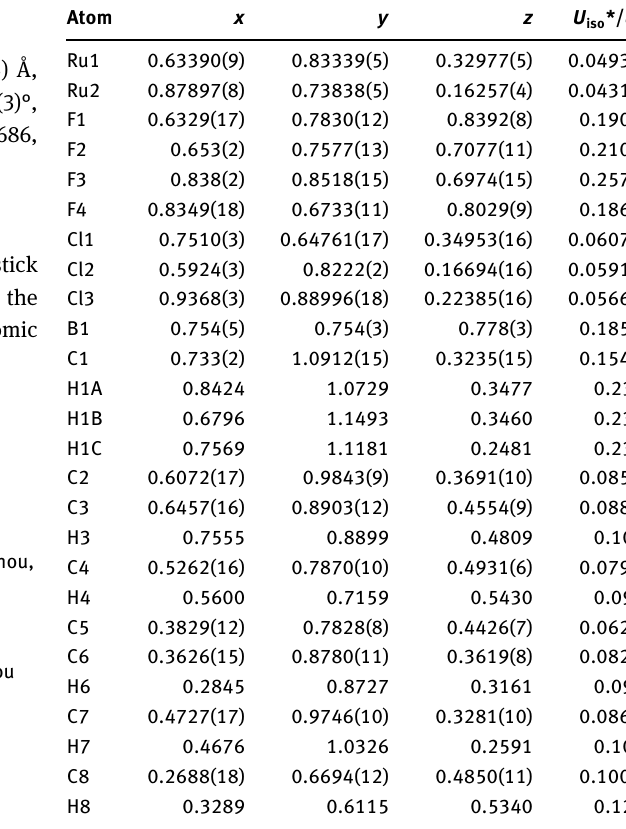
Table 2: Fractional atomic coordinates and isotropic or equivalent isotropic displacement parameters (Å 2